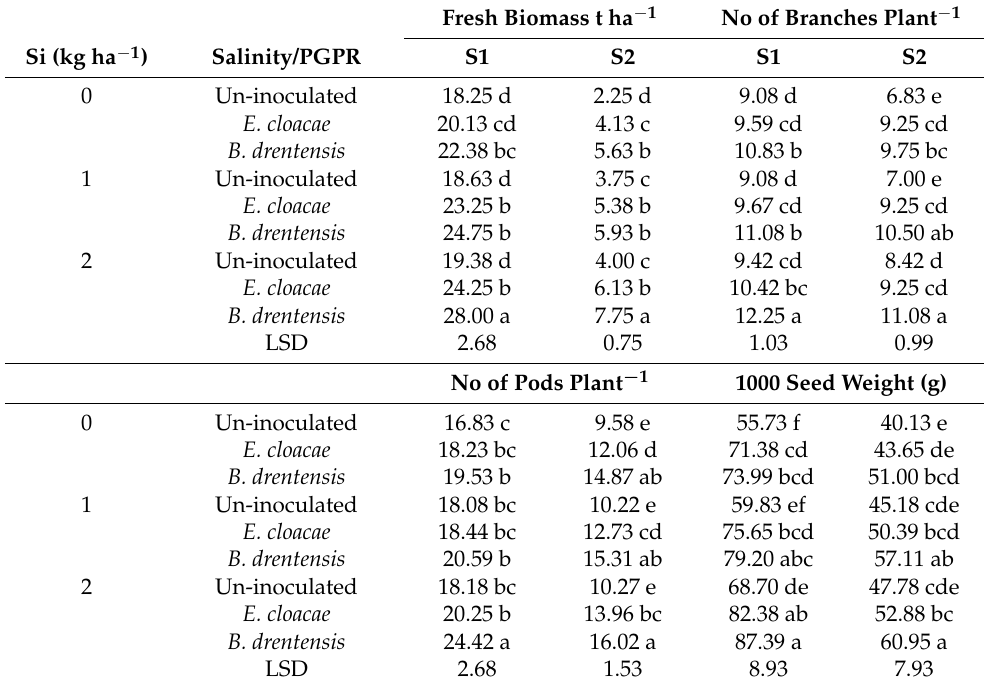
Table 1. Effect of silicon foliar spray and PGPR inoculation on growth and yield of mung bean under saline irrigation conditions. Fresh Biomass t ha − 1 No of Branches Plant − 1 Si (kg ha − 1